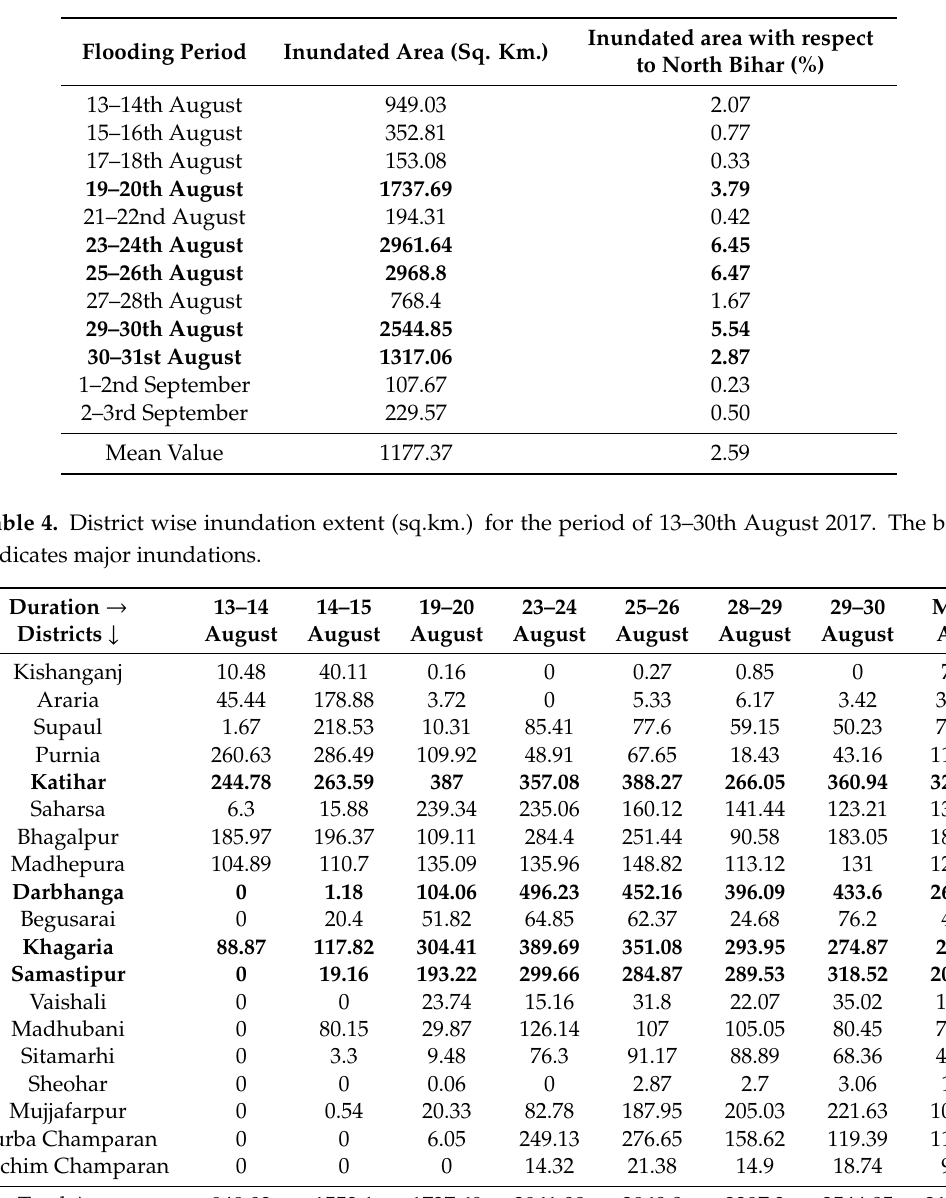
Table 3. MODIS-derived inundated areas (%) with respect to total geographical area of North Bihar (45,903 sq.km). The bold indicates major inundations.